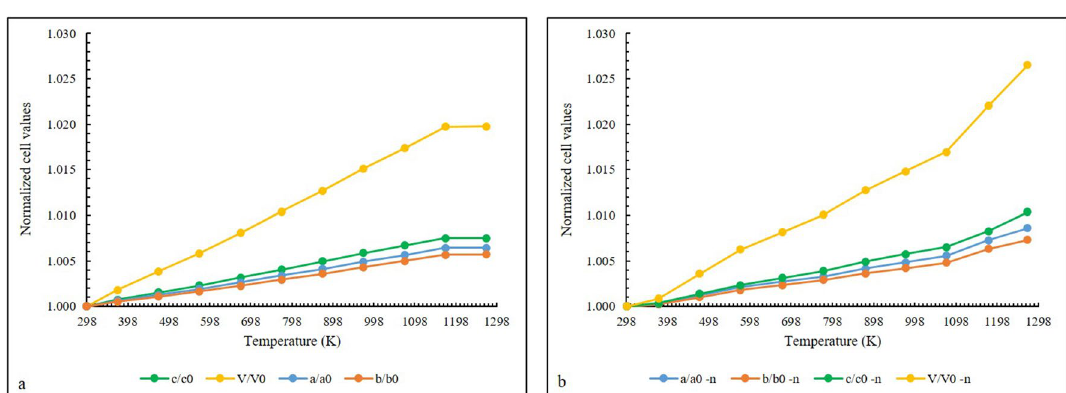
Figure 5. Evolution of unit cell parameters normalized with respect to room temperature values ( a/a 0 , b/ b 0 , c/c 0 , V/V 0 ) from in situ synchrotron ( a ) and neutron diffraction ( b ) data. A strong change in the unit cell parameters evolution is detected from neutron data ( b ), in particular, up to 1075 K a and b cell-axes have a similar expansion rate while the c -axis undergoes an increase up to about 1273 K. Standard deviation errors are within the symbol